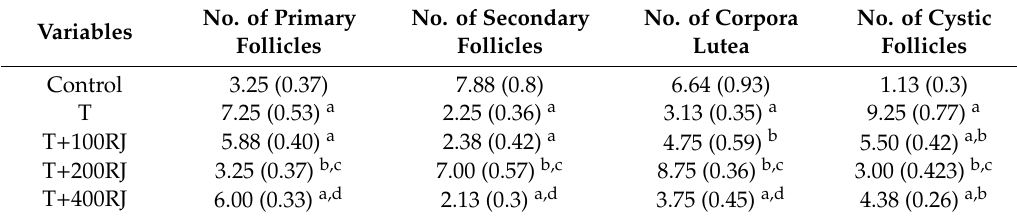
Table 6. The number of primary and secondary follicles, number of corpora lutea, and number of cystic follicles in all experimental